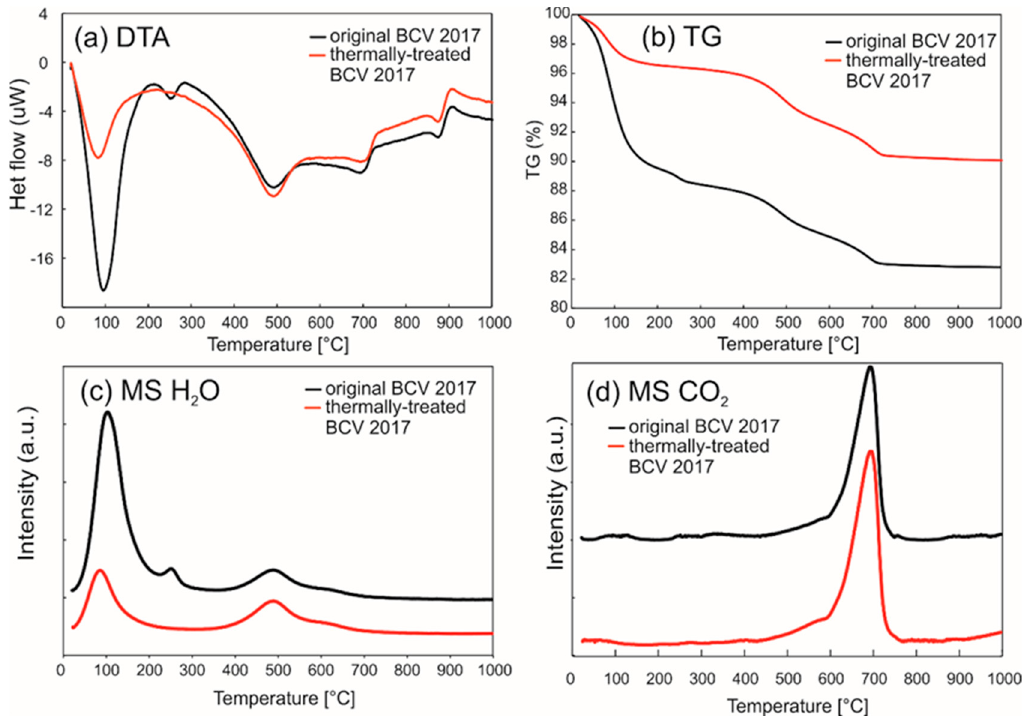
Figure 5. Comparison of ( a ) DTA, ( b ) TG curves and mass spectroscopy signals for ( c ) water and ( d ) carbon dioxide for the original and the thermally treated BCV 2017.